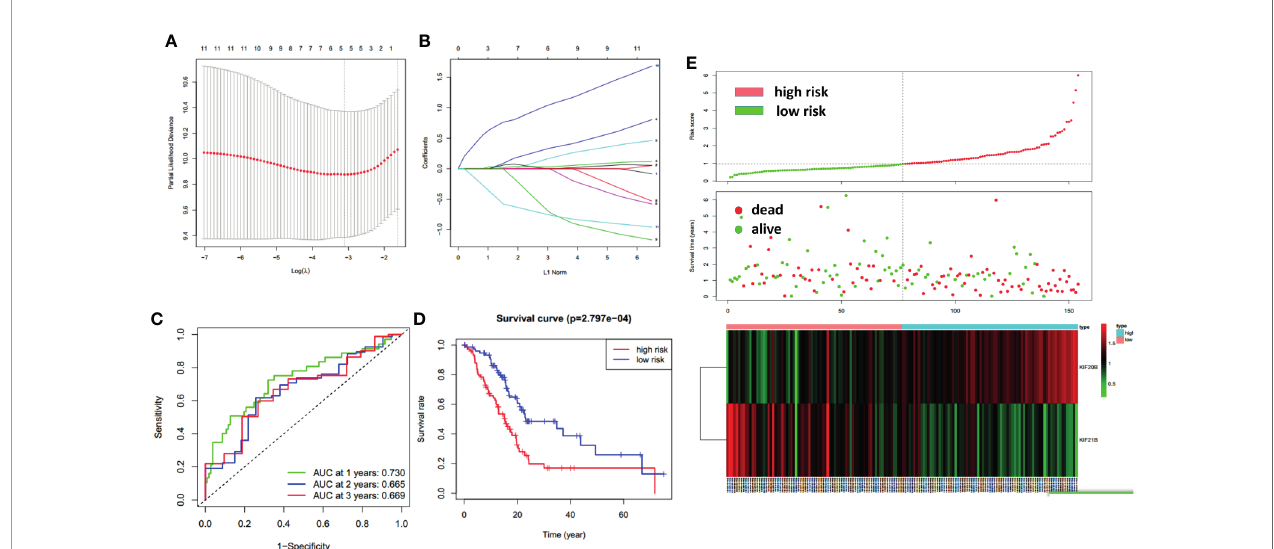
FIGURE 9 | The construction of the two-gene prognostic model. (A) The changing trajectory of every single gene. The vertical axis represents coef fi cients of every single gene, and the horizon axis represents log (lambda) (B) The con fi dence interval at different value of l . (C) Prognostic value of two-gene signature evaluated by ROC curves in TCGA-PAAD cohort. (D) Survival analysis of two-gene signature using Kaplan – Meier survival curves. (E) The distribution of survival status and expression pro fi le of KIF20B and KIF21B between risk group.